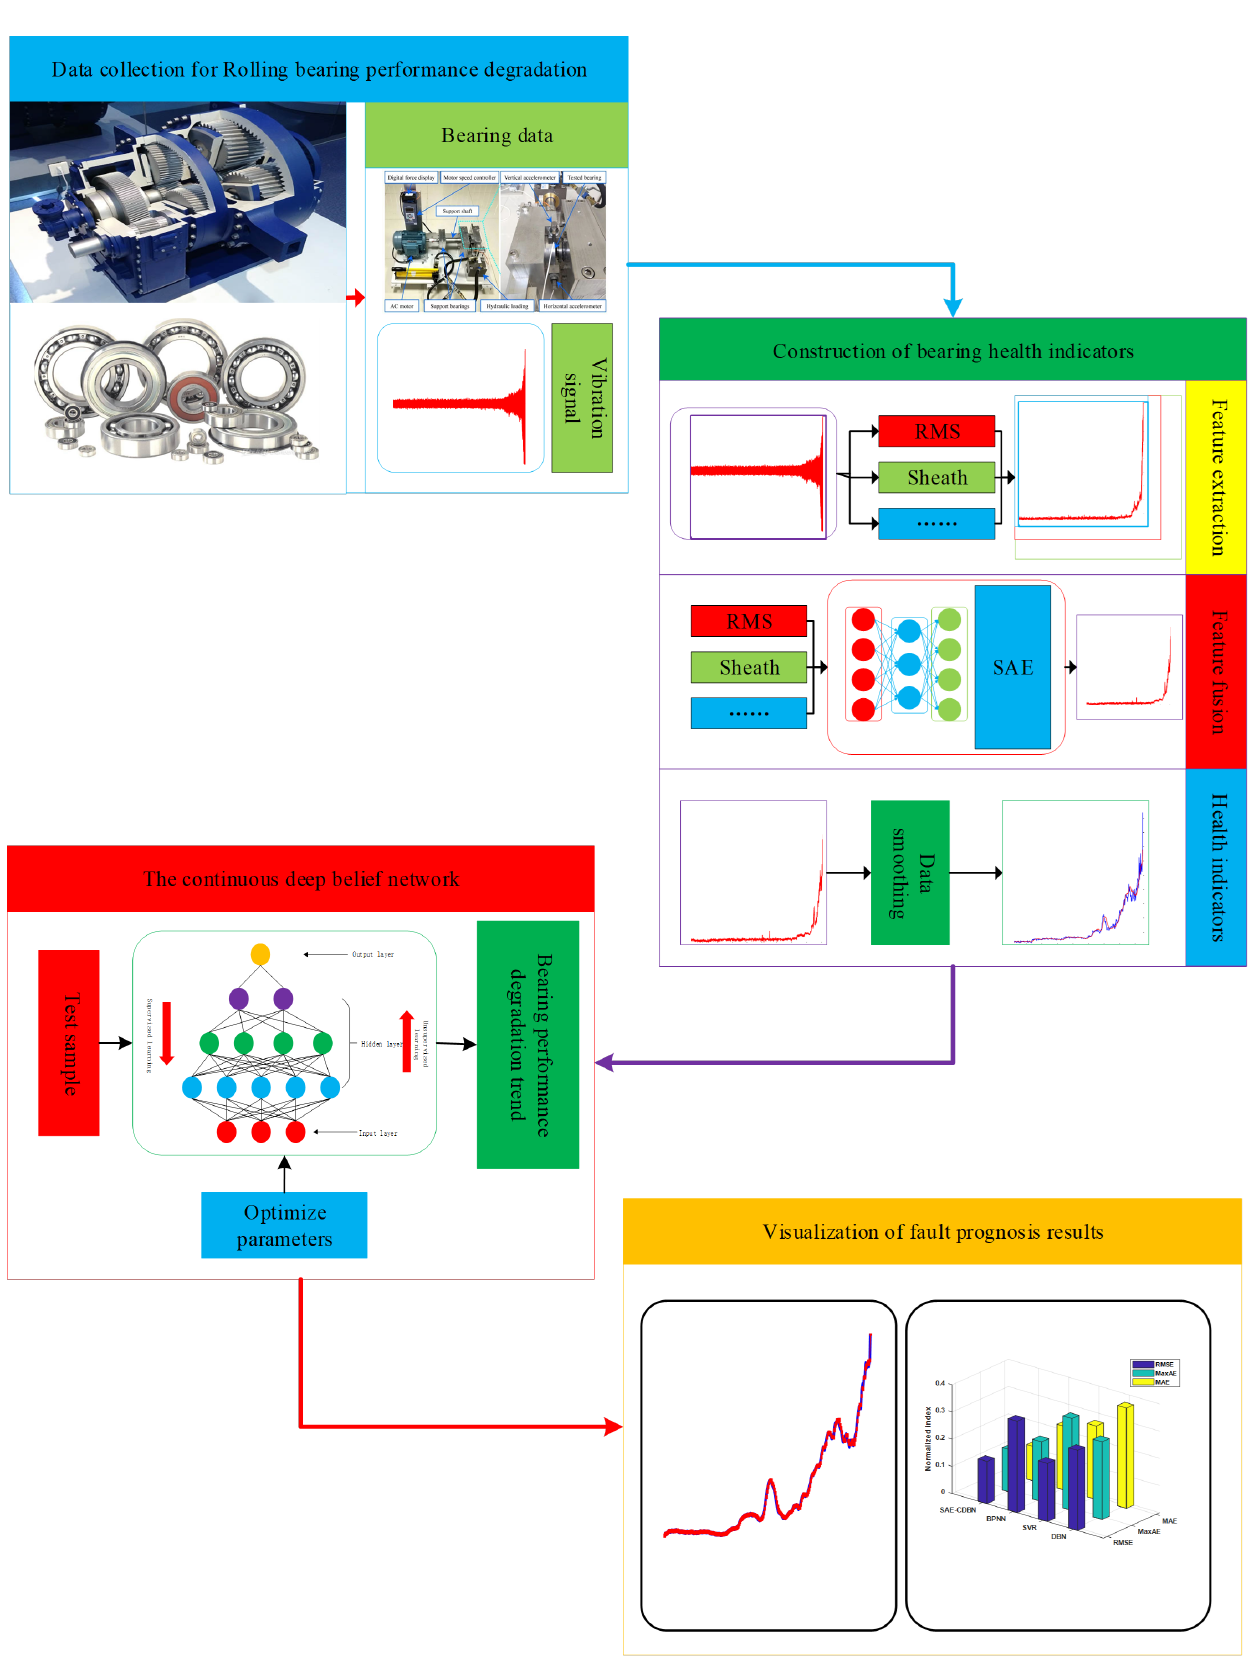
Figure 4. Bearing fault prognosis steps based on the proposed